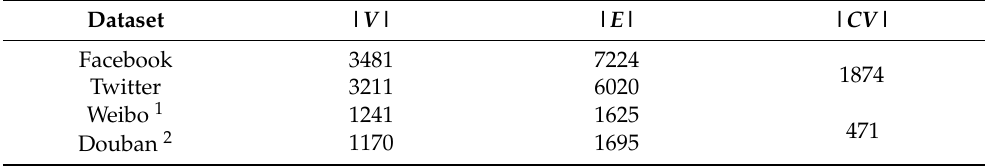
Table 2. The information of